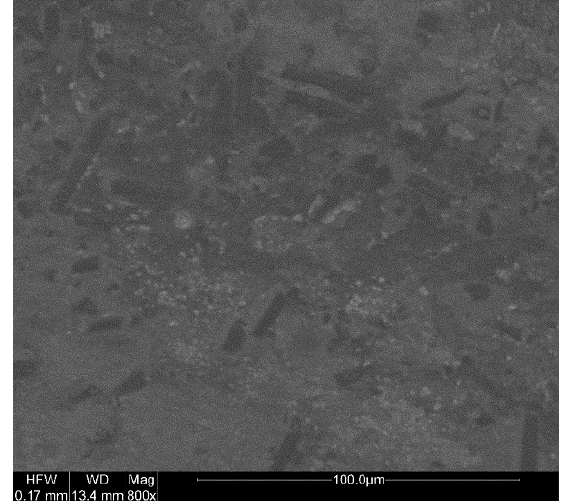
Materials 2019 , 12 , x FOR PEER REVIEW Figure 8. X–Y plane of the polylactic acid–carbon fiber specimen. Figure 8. X–Y plane of the polylactic acid–carbon fiber specimen. 187